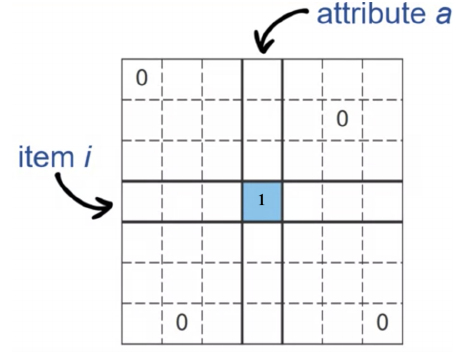
Figure 4. Item content matrix.